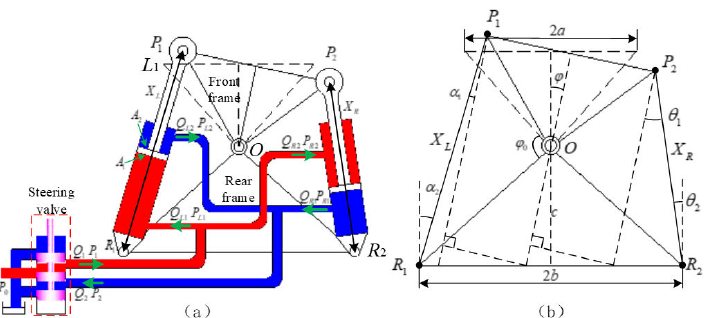
Figure 3. The ASV steering system. ( a ) The hydraulic circuit of the steering system; ( b ) the geometric relationship of the